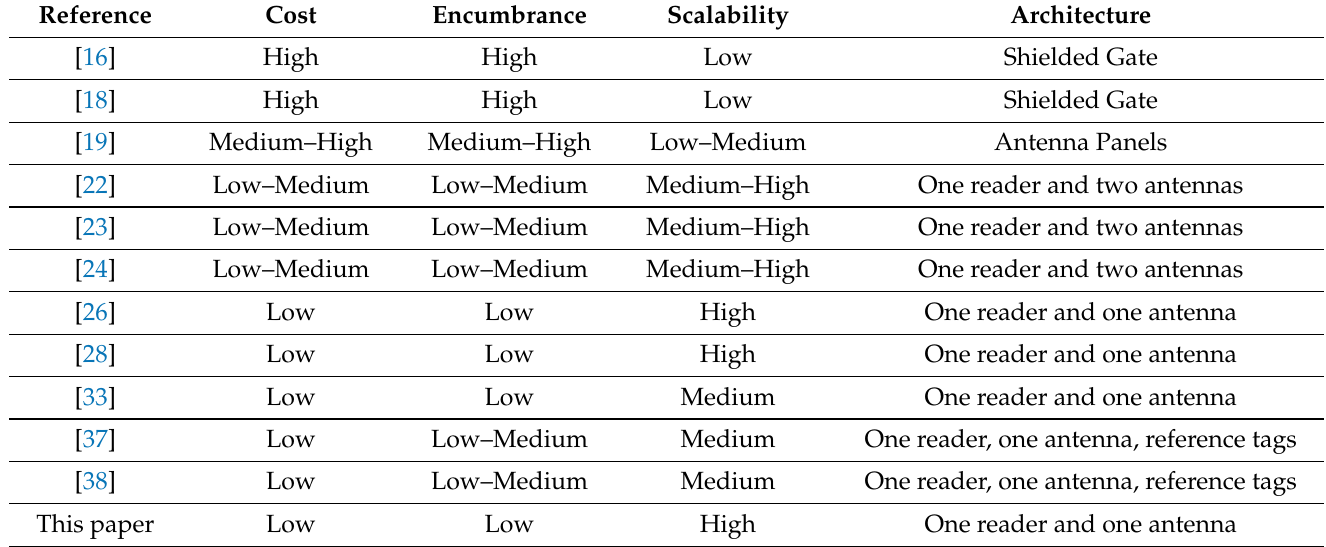
Table 2. Comparison of the proposed solution with the